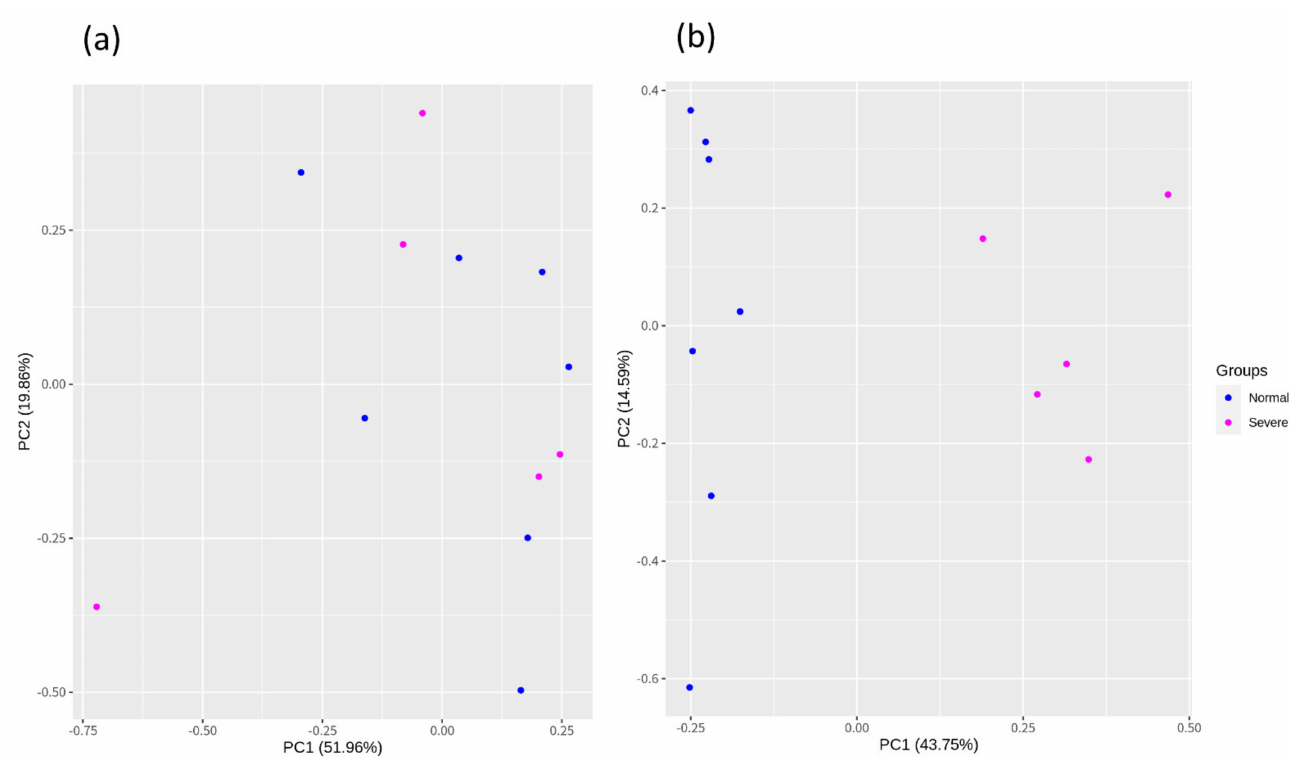
Figure 2. The batch correction using the RUVr function of the RUVSeq package; principal component was further divided into two groups: ( a ) before batch correction and ( b ) after batch correction using